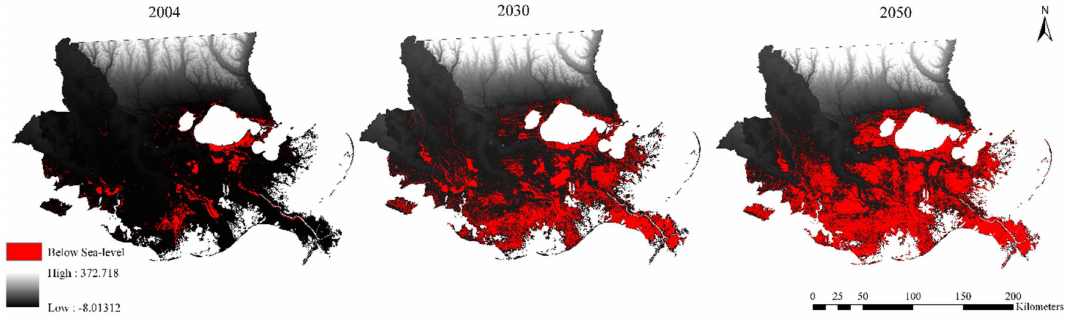
Figure 6. Projected elevation map with areas below sea